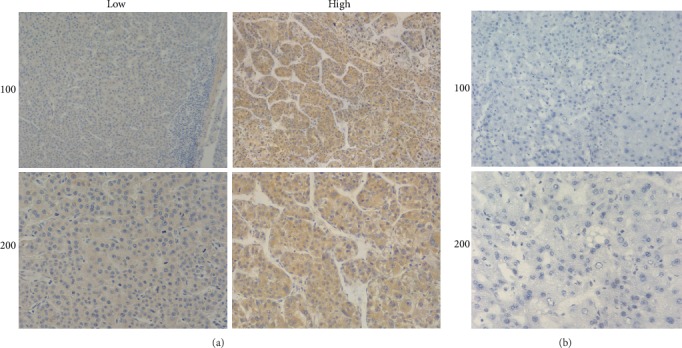
KIF15 expression was associated with poor prognosis of patients who underwent HCC. (a) Immunohistochemical staining of KIF15 protein in human HCC tissues (×100 and ×200 magnification, respectively). (b) Immunohistochemical staining of KIF15 in the corresponding adjacent tissues (×100 and ×200 magnification, respectively).